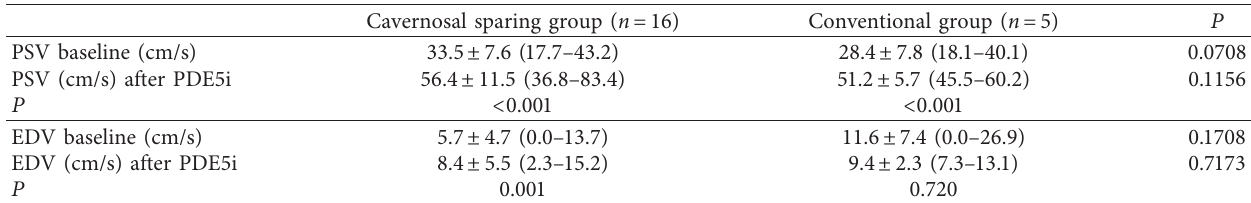
Table 2: Postoperative measurements of spared cavernosal artery (mean ± SD,